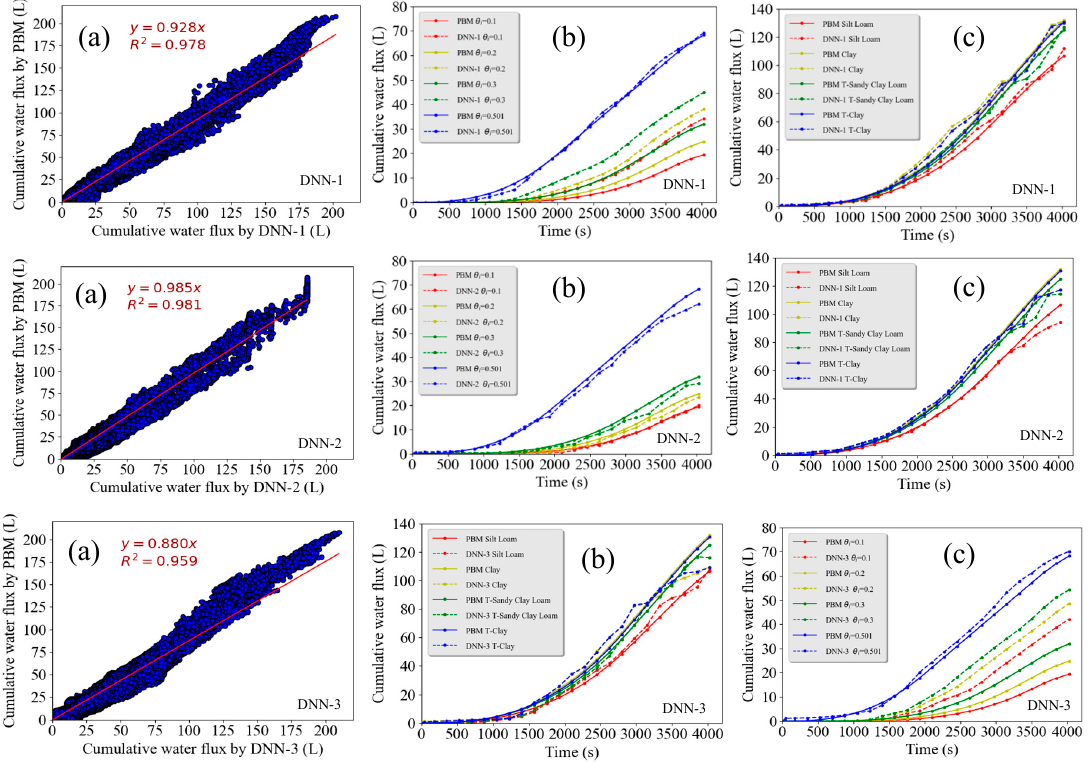
Figure 7. Comparison of cumulative water fluxes ( Q c in liters, L) calculated by the PBM and the Deep Feed-Forward Neural Network (DNN-1 ( top row ), DNN-2 ( middle row ), and DNN-3 ( bottom row )) models (( a ) overall, ( b ) different initial water contents, ( c ) different textures)).